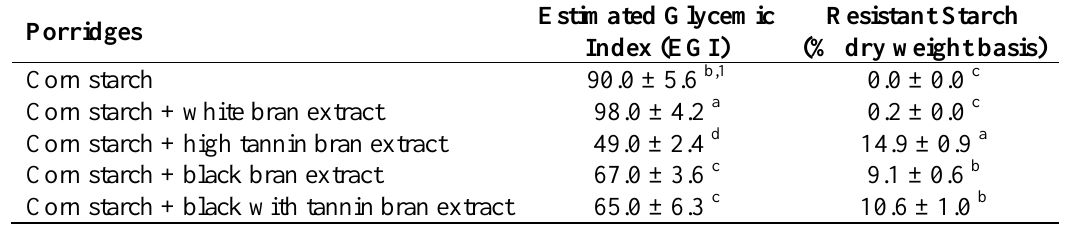
Table 3. Estimated Glycemic Index (EGI) and Resistant Starch (RS) Contents of Corn Starch Porridge Cooked with Sorghum Bran Extracts.